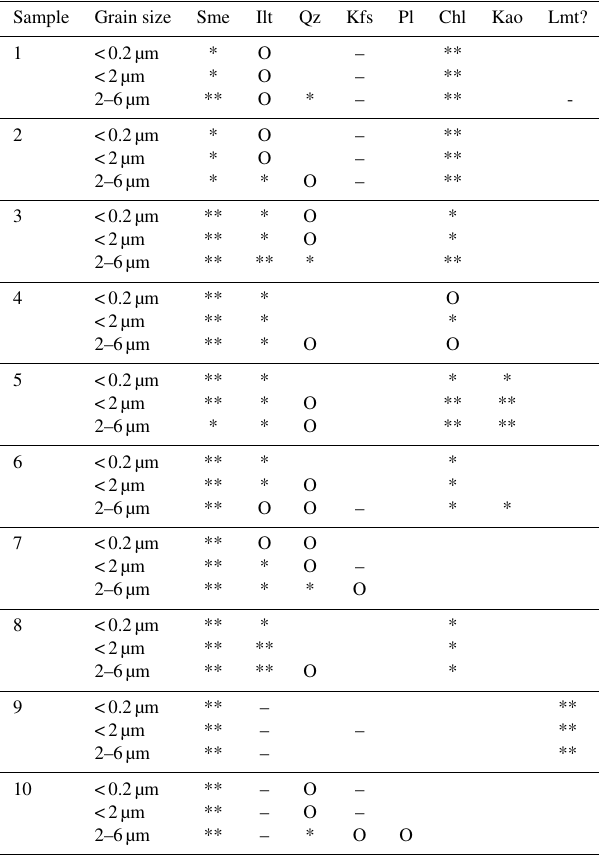
Table 1. Mineral composition of dated fault gouges. “Presumed traces” are based on inclined spectra (Appendix A) showing peaks at 27.3–27.4KeV for K-feldspar, and on the presence of minor illite in smectite, enabling K–Ar dating, e.g., samples 9 and 10. Abbre- viations are as follows: Chl is chlorite; Ilt is illite; Kao is kaolinite; Kfs is K-feldspar; Lmt is laumontite; Pl is plagioclase; Qz is quartz; Sme is smectite. The question mark indicates uncertainty around the nature of the mineral here interpreted as